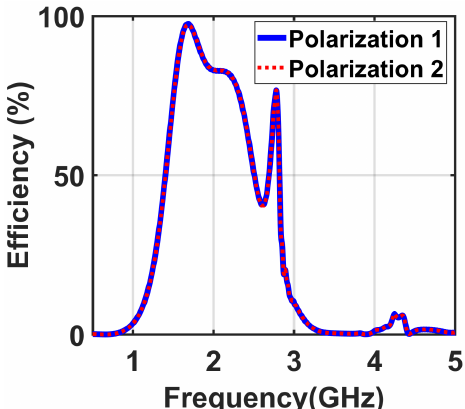
Figure 5. Numerical results of the presented dual polarized planar 2 × 2 supercell, showing the radiation to AC efficiency of the supercell for both